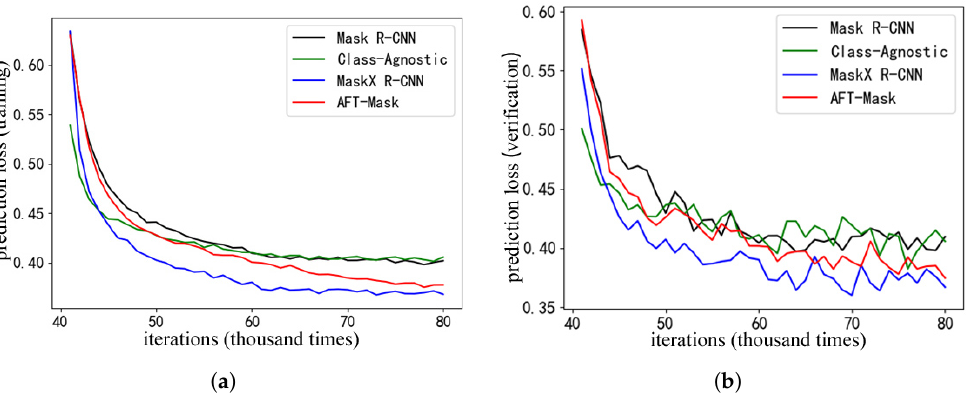
Figure 4. Comparison of prediction loss with iteration number by correlation model segmentation. ( a ) Training loss. ( b ) Validation